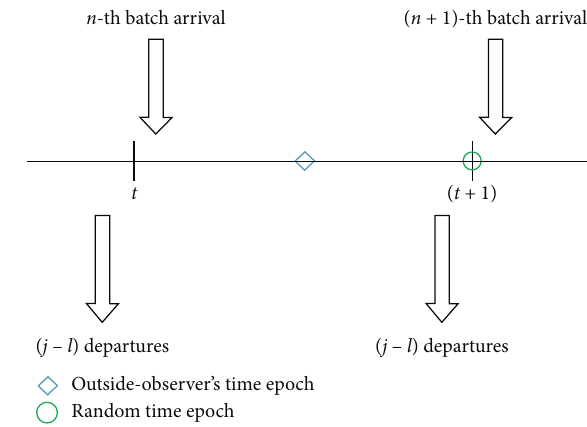
Figure 3: Outside observer’s and random time epochs in GI X / Geo / c with EAS.